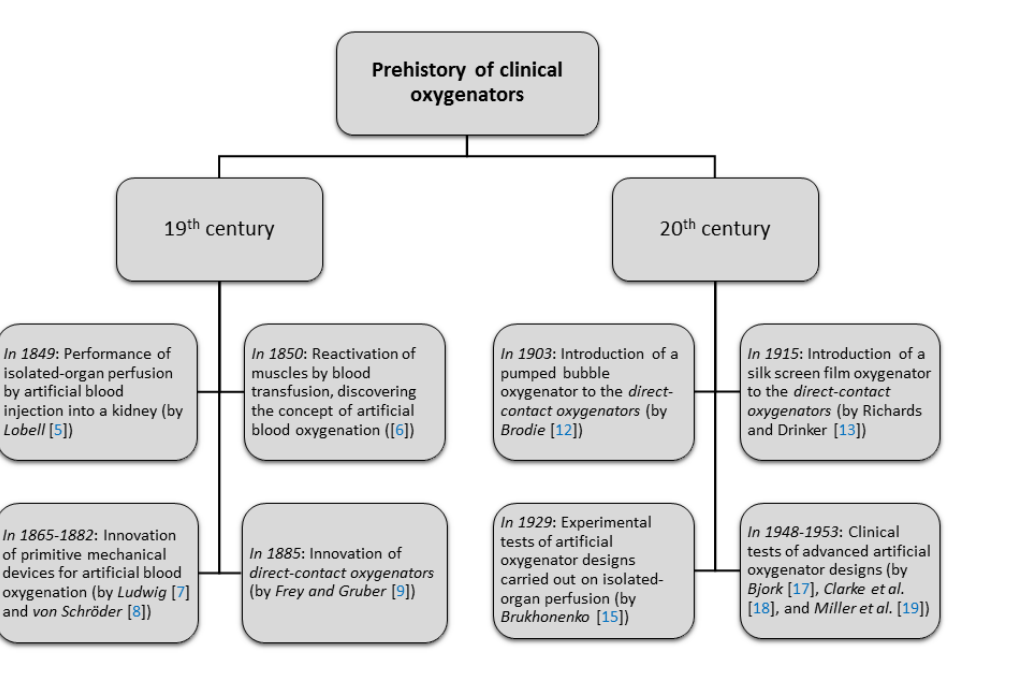
Figure 2. Historical milestones in the evolution of lung assist